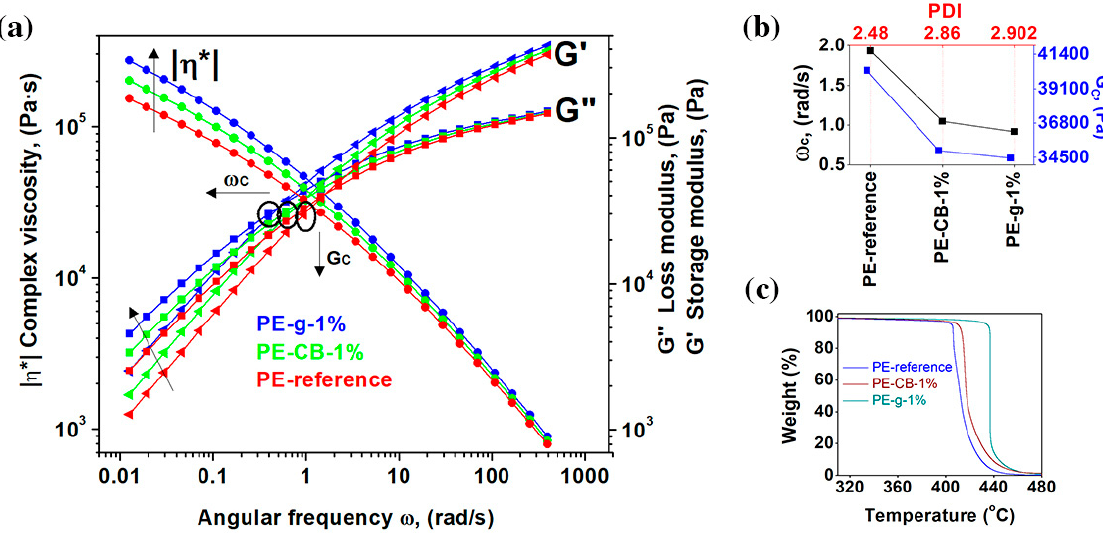
Figure 2. Thermal stability and rheological behaviours of the multimodal-HDPE and its nanocomposites ( a ) Dynamic frequency sweep measurements of the multimodal-HDPE reference (PE), PE-CB-1% and PE-g-1%, measured at 190 °C. ( b ) The polydispersity index (PDI) of the neat polymer and its nanocomposites, calculated based on the crossover frequency point ( ω C ) and the crossover modulus point ( G C ) in a log-log scale. ( c ) Thermogravimetric thermograms of the neat multimodal-HDPE, PE-CB-1% and PE-g-1%, in N 2 atmosphere.